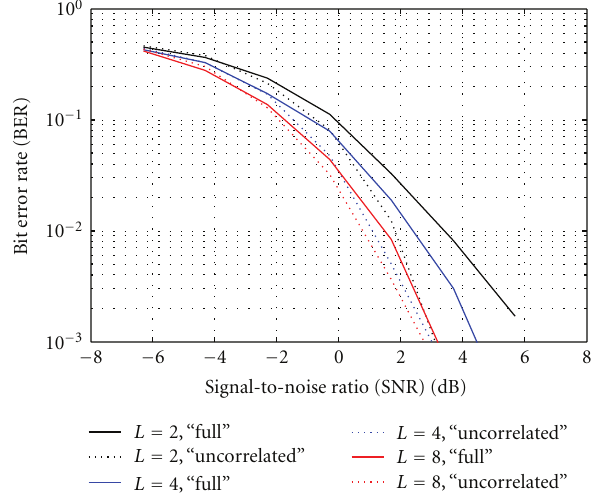
ff erent codebook sizes (partial feedback